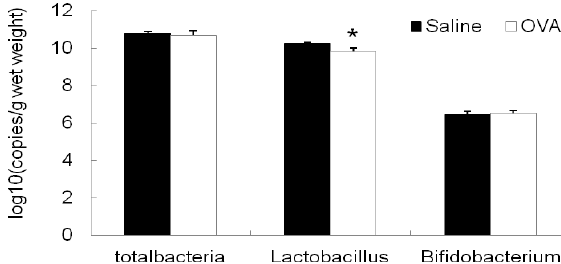
Figure 5. Quantitative real-time PCR Analysis of total bacteria, Lactobacillus and Bifidobacterium in the colon of saline sensitized (■) and OVA sensitized (□) mice. (n = 5 mice/group; mean  SE; *